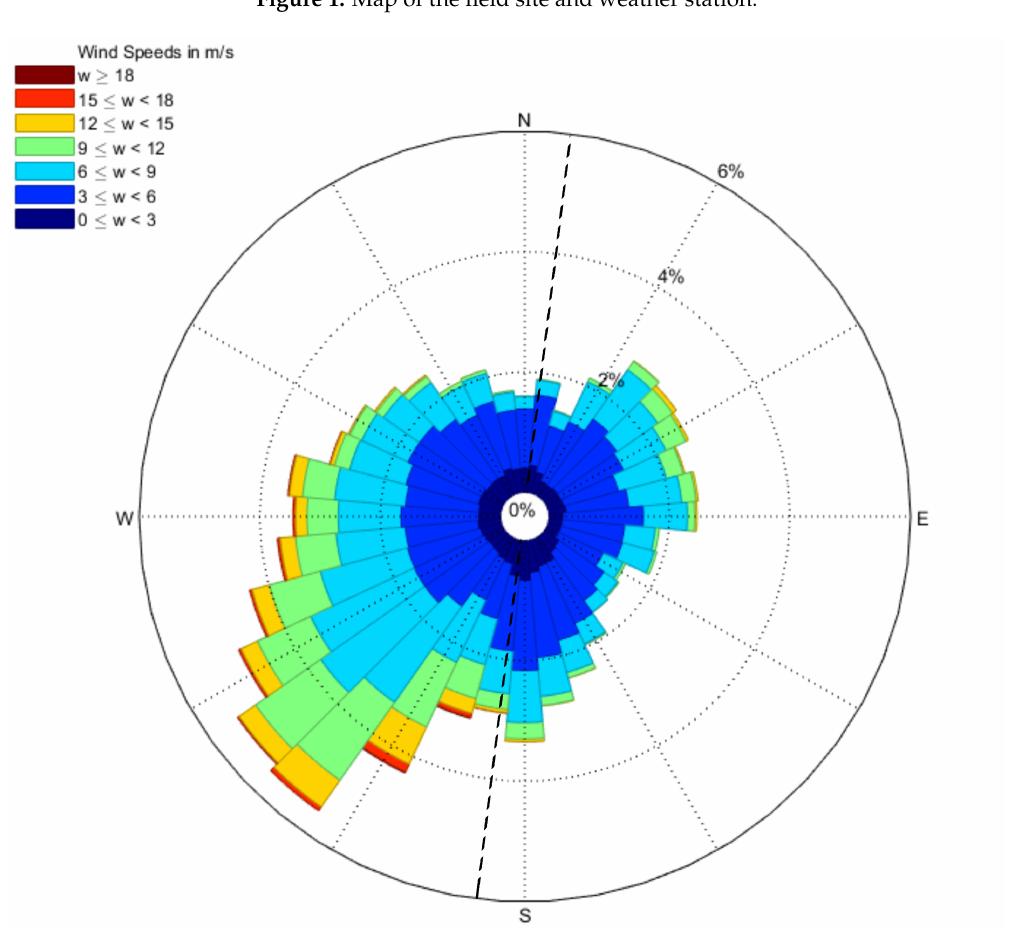
Figure 2. Wind rose based on hourly wind speed U and direction θ data collected between 2005 and 2012 at de Kooy, approximately 40 km north of our study site. The dashed line indicates the orientation of the coast. The data are made available with a resolution of 1 m/s for U and 10 ◦ for θ . The anemometer and wind vane are located at a height of 10 m above ground